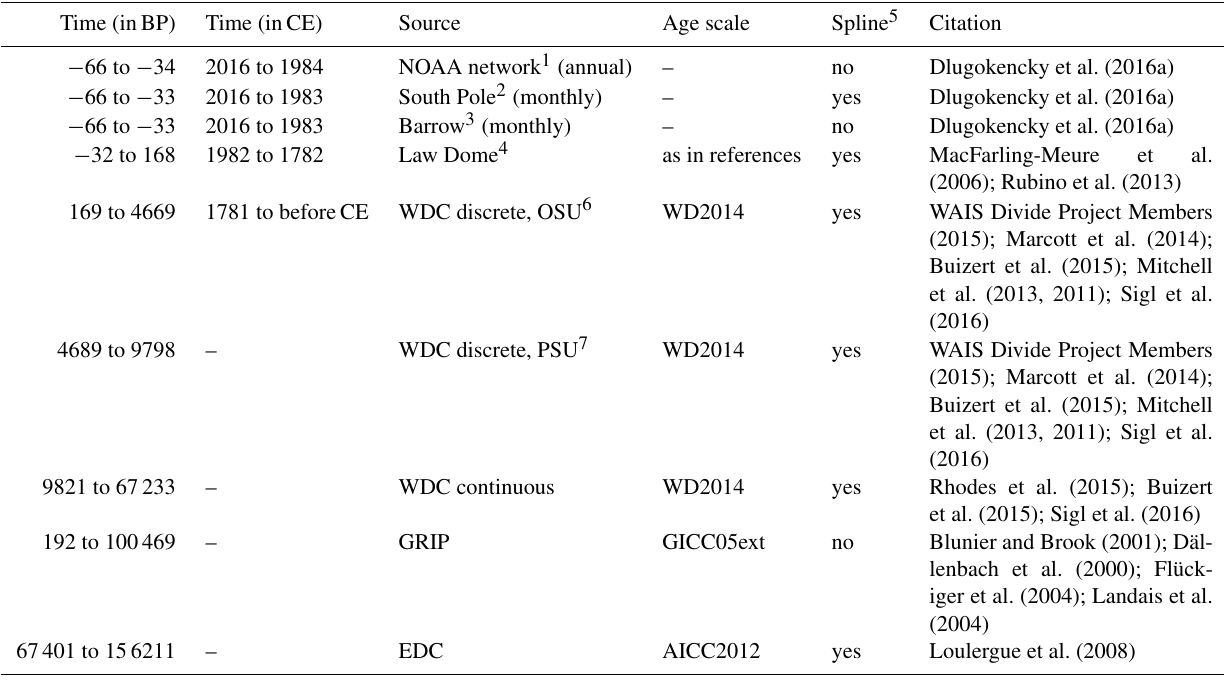
Table 5. Data used to construct (or compare to) the Southern Hemisphere CH 4 spline. Time